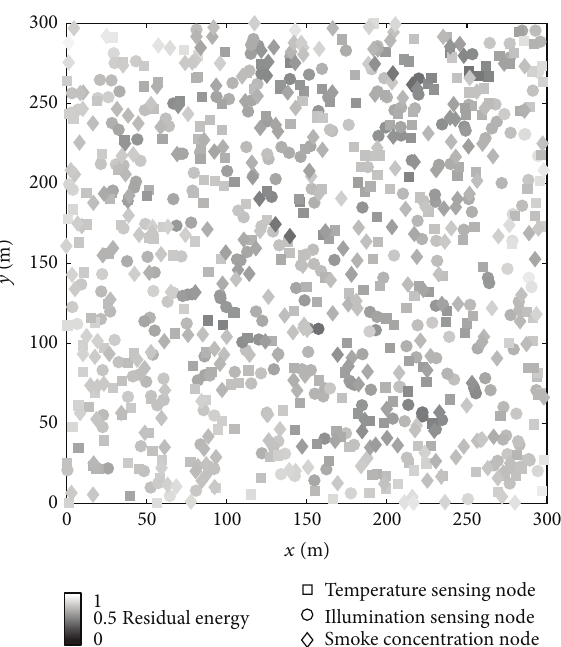
Figure 12: Energy distribution of DS algorithm after 250